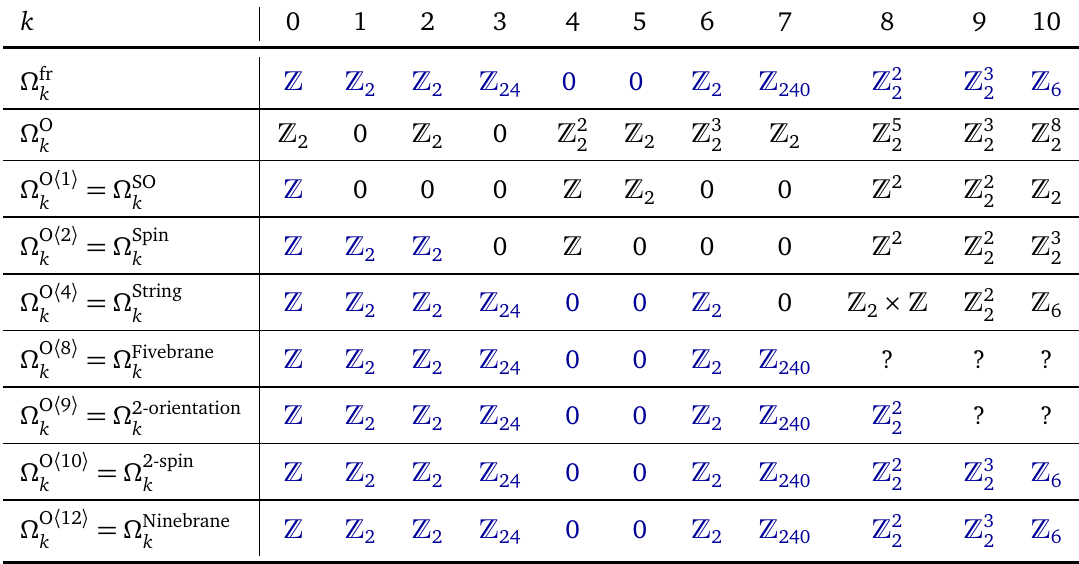
〈 n 〉 Table 2: Bordism groups Ω O for various dimensions k ; note that Ω O k 〈 10 〉 Ω O 〈 4 〉 = Ω O 〈 5 〉 = Ω O 〈 6 〉 = Ω O 〈 7 〉 = Ω O 〈 11 〉 , and Ω O by Bott periodicity. We highlight k k k k k k in blue the realisation of the isomorphism